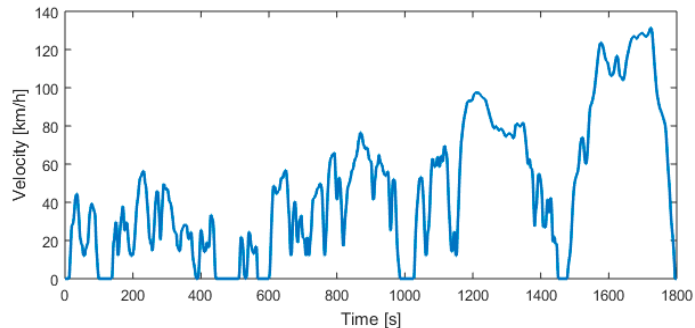
Figure 7. Worldwide harmonised light duty driving test cycle (WLTC) driving cycle.